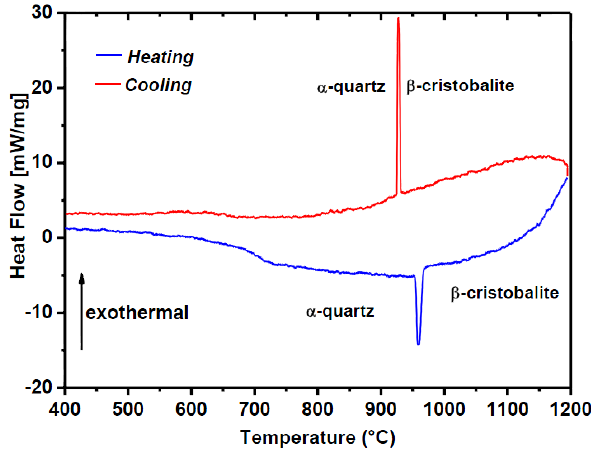
Figure 3. Differential scanning calorimetric (DSC) curves of powdered flux-grown α-GaPO crystals registered with a thermal cycle of 2